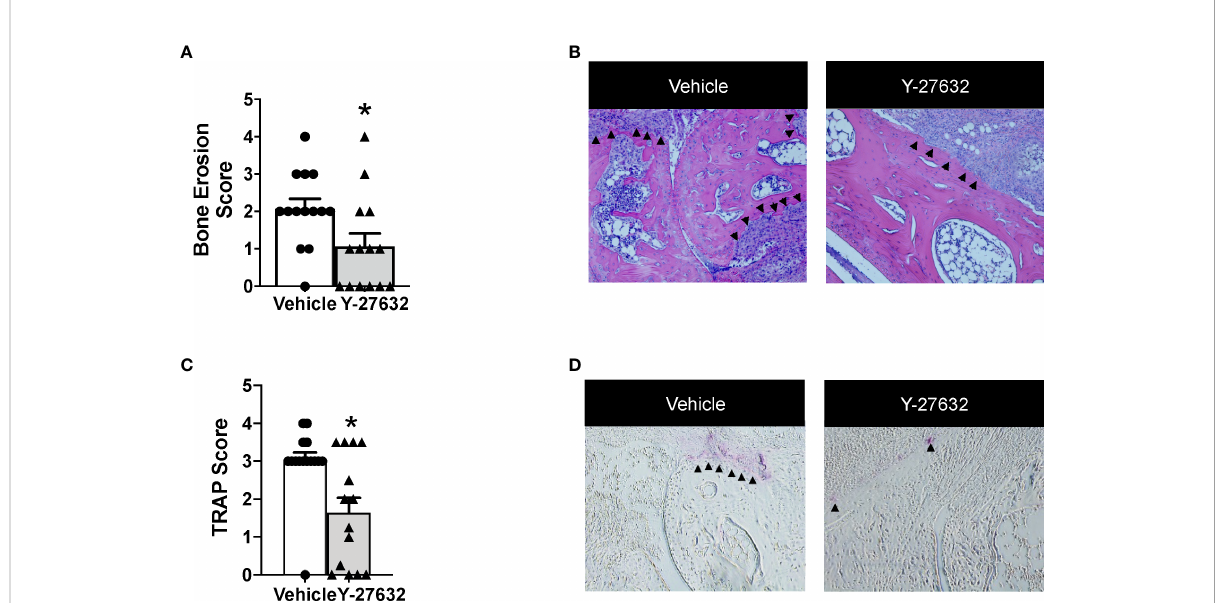
FIGURE 3 Treatment with Y-27632 decreased bone erosion in arthritic mice. Comparison of the histologic score of bone erosion (A) and tartrate-resistant acid phosphatase (TRAP) activity score (C) in the joints of the same mice shown in Figure 2. Representative images of bone erosion (B) and TRAP activity (D) assessment. ▲ indicates invasive pannus tissue penetrating into subchondral bone areas (B) and TRAP + bone resorbing osteoclasts (D) in the two groups of mice. Values are the Mean ± SEM. *p < 0.05 (Mann-Whitney